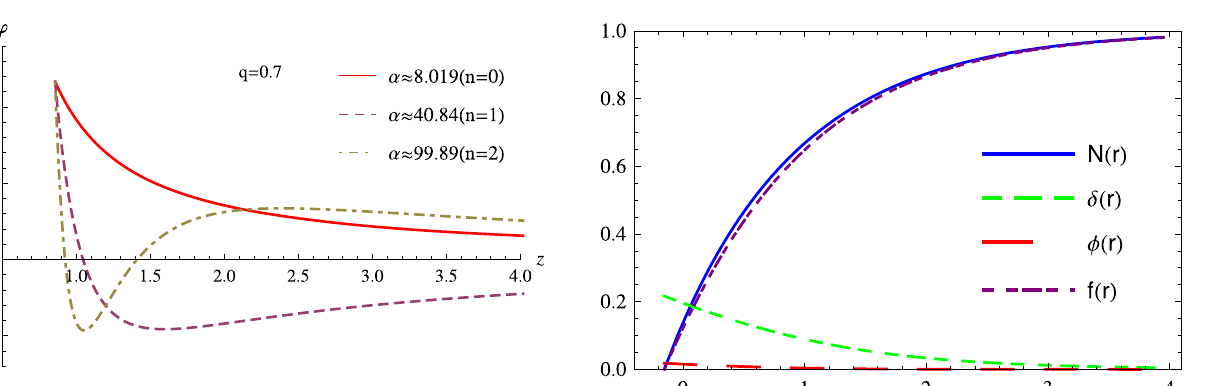
Fig. 1 Radial profiles of ϕ( z ) as function of z = r /( 2 M ) for the first three perturbed scalar solutions on the RN black hole with q = 0 . 7. Here n represents the node number of ϕ( z ) and it will denote the order number for labelling different scalarized black holes black hole determines the appearance of n = 1 , 2 . . . black